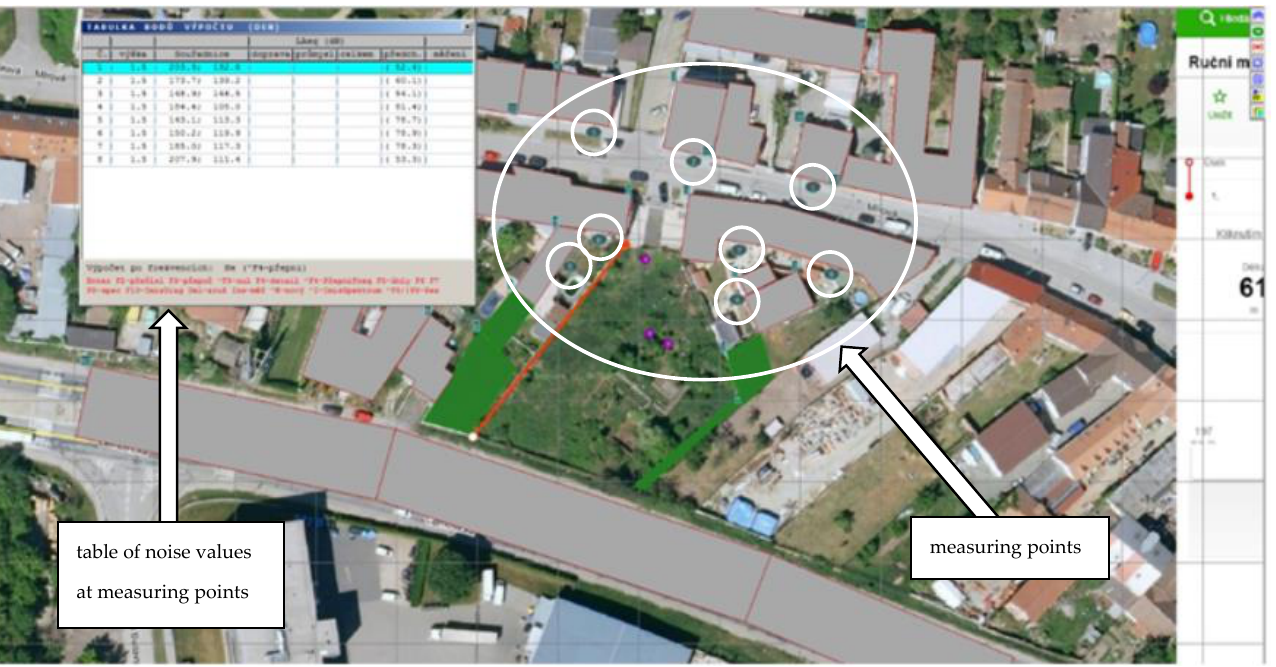
Figure 5. Acoustically significant elements of the investigated area, with the positions of construction machines as sources of noise, with simultaneous deployment.